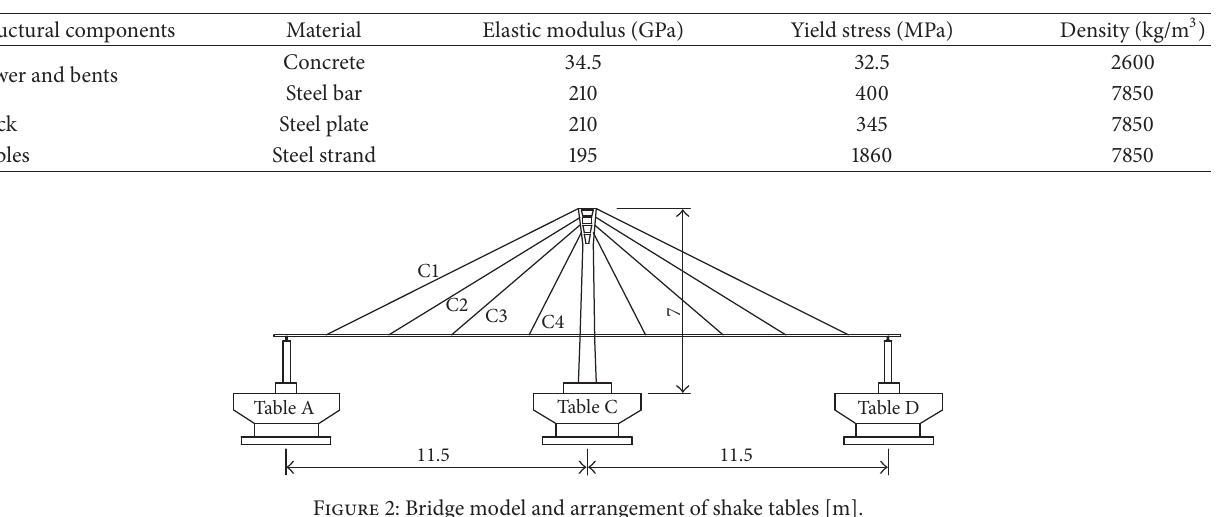
Figure 2: Bridge model and arrangement of shake tables [m].